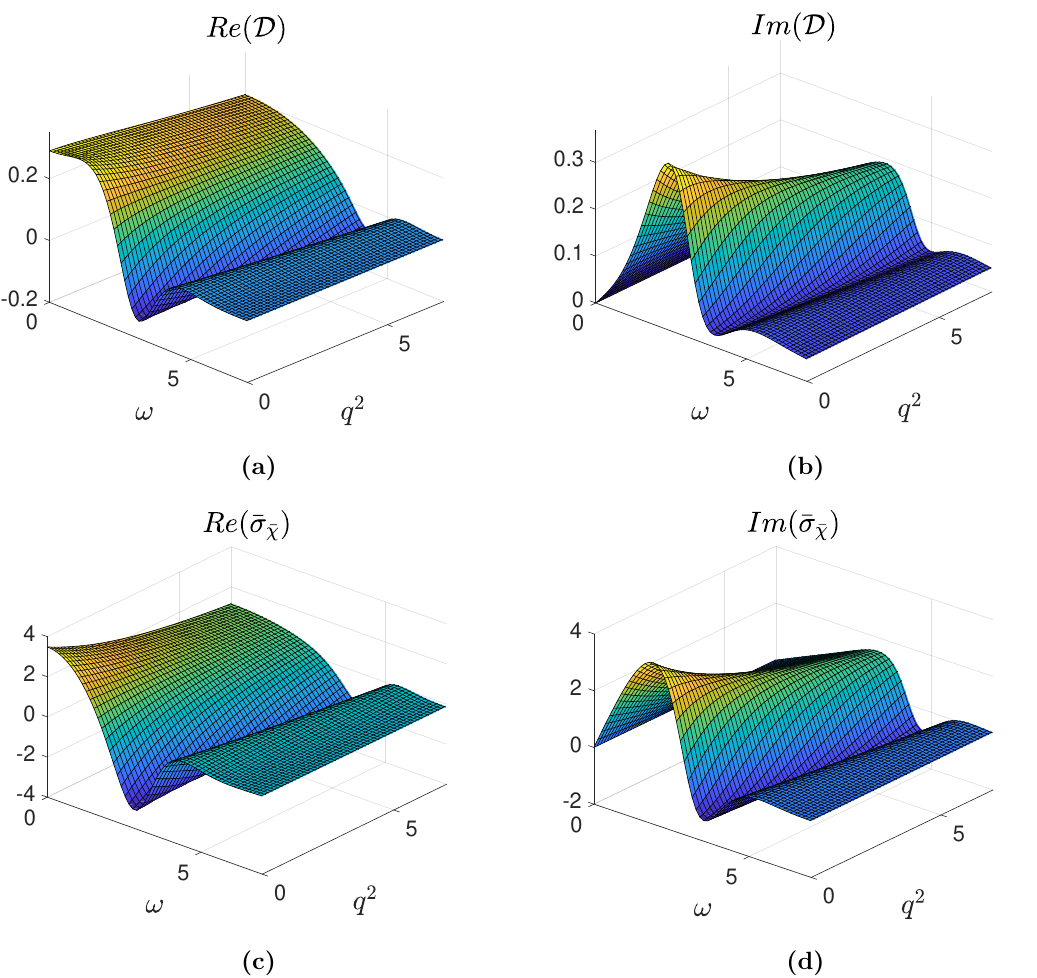
Figure 7. Di(cid:11)usion function D and generalised CME/CSE conductivity (cid:22) (cid:27) (cid:22) (cid:31) as functions of ! and q 2 when (cid:20) B = 0 : 25 and (cid:11) = 0.